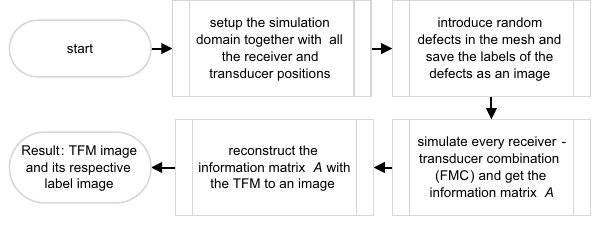
Fig. 3 Flow chart of the simulation procedure for generating one